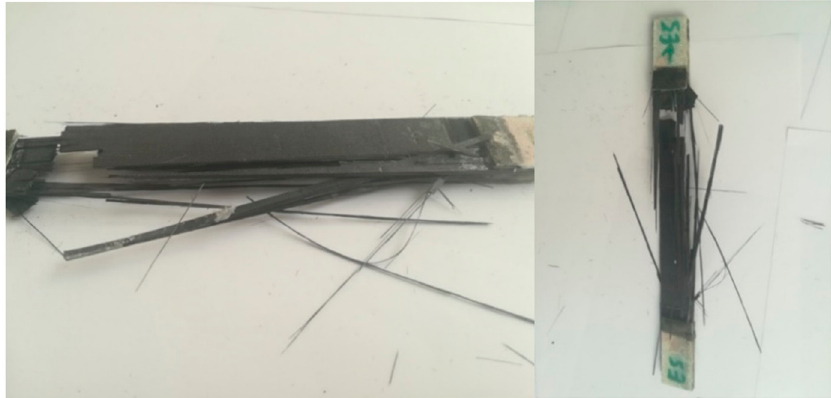
Figure 21. Appearance of samples from the E series after tensile bench testing.